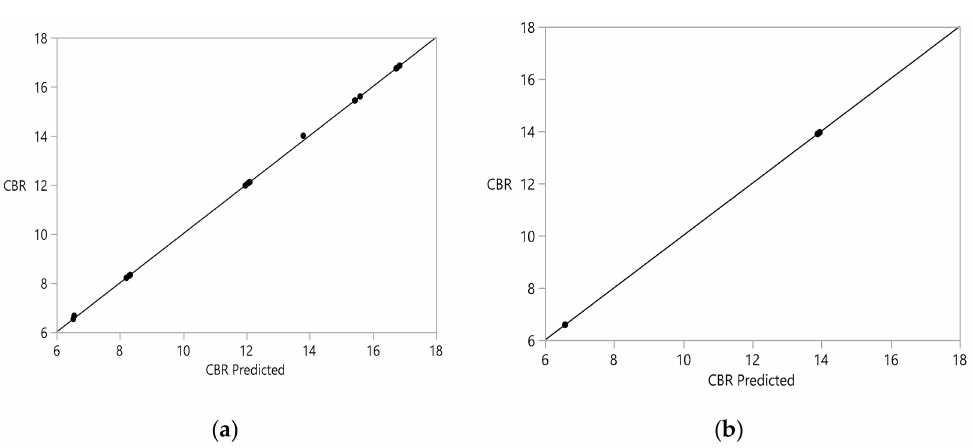
Figure 5. Training and Validation Data Plot for CBR Predicted versus Actual CBR. ( a ) Training; ( b ) Validation.